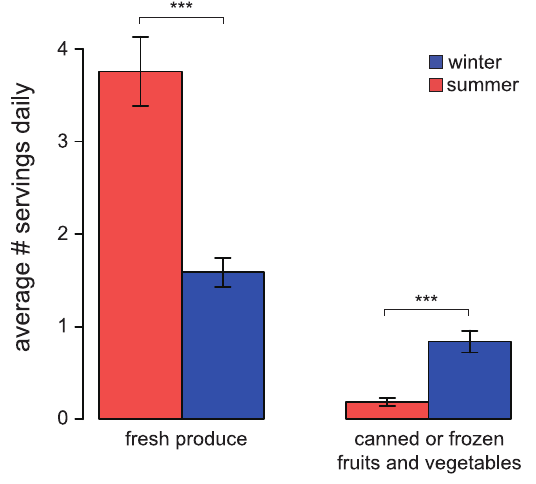
Figure 5. Produce consumption varies by season. In summer, when fruits and vegetables are grown in colony gardens, consumption of fresh produce is higher than in winter. Conversely, when fresh produce is not as available, a higher proportion of canned or frozen fruits and vegetables are eaten. Bars indicate standard error measure- ments. *** P , 0.001 (t-test, adjusted for multiple tests using Benjamin Hochberg correction). See Table S6 for a list of all tests performed.